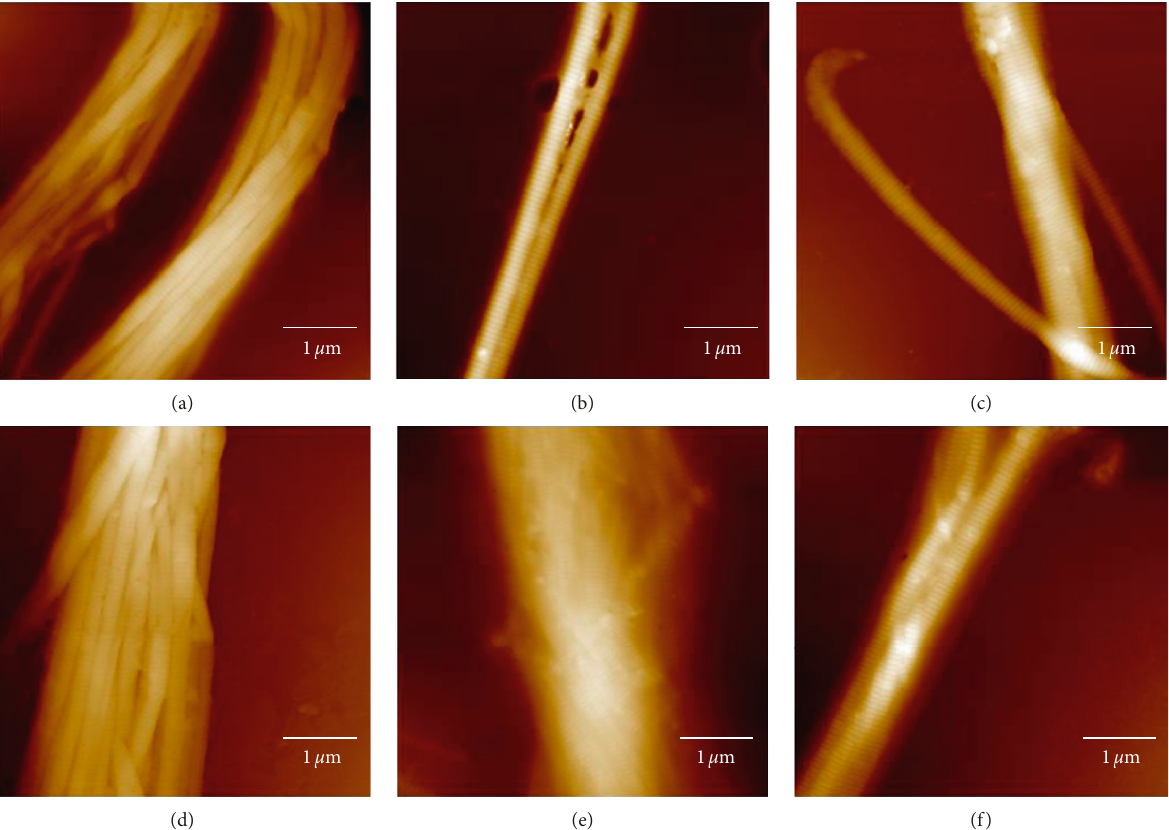
Figure 2: Typical AFM height images of collagen fibrils treated by ultrasound at different frequencies: (a–c) 10-minute group and (d–f) 20- minute group were processed at 20, 28, and 40kHz,